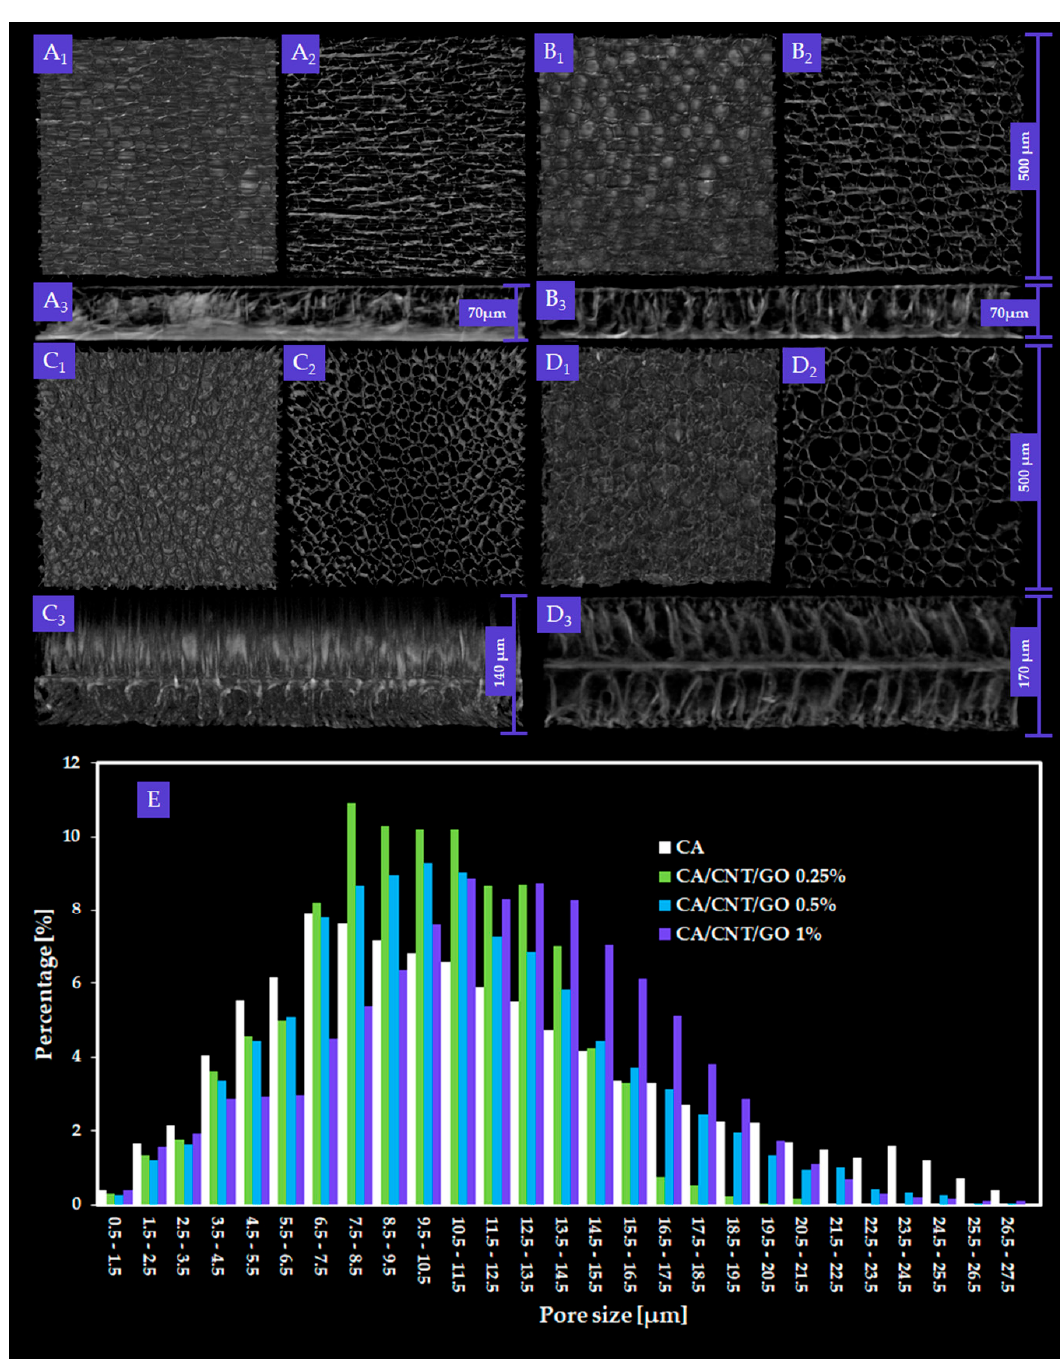
Figure 1. Three-dimensional (3D) renderings of: cellulose acetate (CA) ( A1 ) top view, ( A2 ) transversal section, and ( A3 ) cross-section; CA, carbon nanotubes, and graphene oxide (CA-CNT-GO) 0.25% ( B1 ) top view, ( B2 ) transversal section, and ( B3 ) cross-section; CA-CNT-GO 0.5% ( C1 ) top view, ( C2 ) transversal section, and ( C3 ) cross-section; and CA-CNT-GO 1% ( D1 ) top view, ( D2 ) transversal section, and ( D3 ) cross-section; with measured pore size distribution ( E ). Overall, for images A1–2, B1–2, and C1–2, scale bar is 500 µm. Widths of membrane cross-section are scaled particularly . Wall and pore measurements were completed after a classic two-step image processing technique. Reconstructed tomograms are monochromes consisting of spectra of grey shades pixels spanning from white to black. First, thresholding is a binary filter which parts the greyscale spectra in two with a limit grey tone value. The thresholding value (9 to 255 greyscale) is manually selected